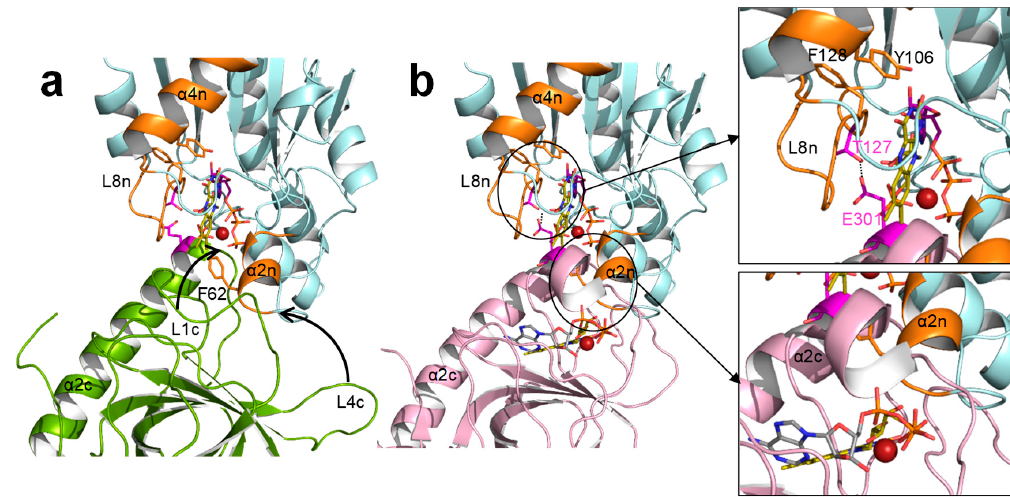
Figure 9. The head-to-tail conformation in the dimer-of-trimers assembly of Ca FADS. ( a ) Interface between RFK (green) and FMNAT (blue) modules of two contiguous protomers (PDB 2x0k) showing the open conformation of the RFK module. ( b ) Replacement in (a) of the RFK module by the closed conformation observed upon binding of the RFK activity products (pink) (PDB 5a89) and detail of the predicted T127-E301 H-bond [25], and the steric hindrance of structural elements in the closed RFK conformation of the trimeric structure. The required movement of loops for attaining this conformation are indicated with an arrow in (a).